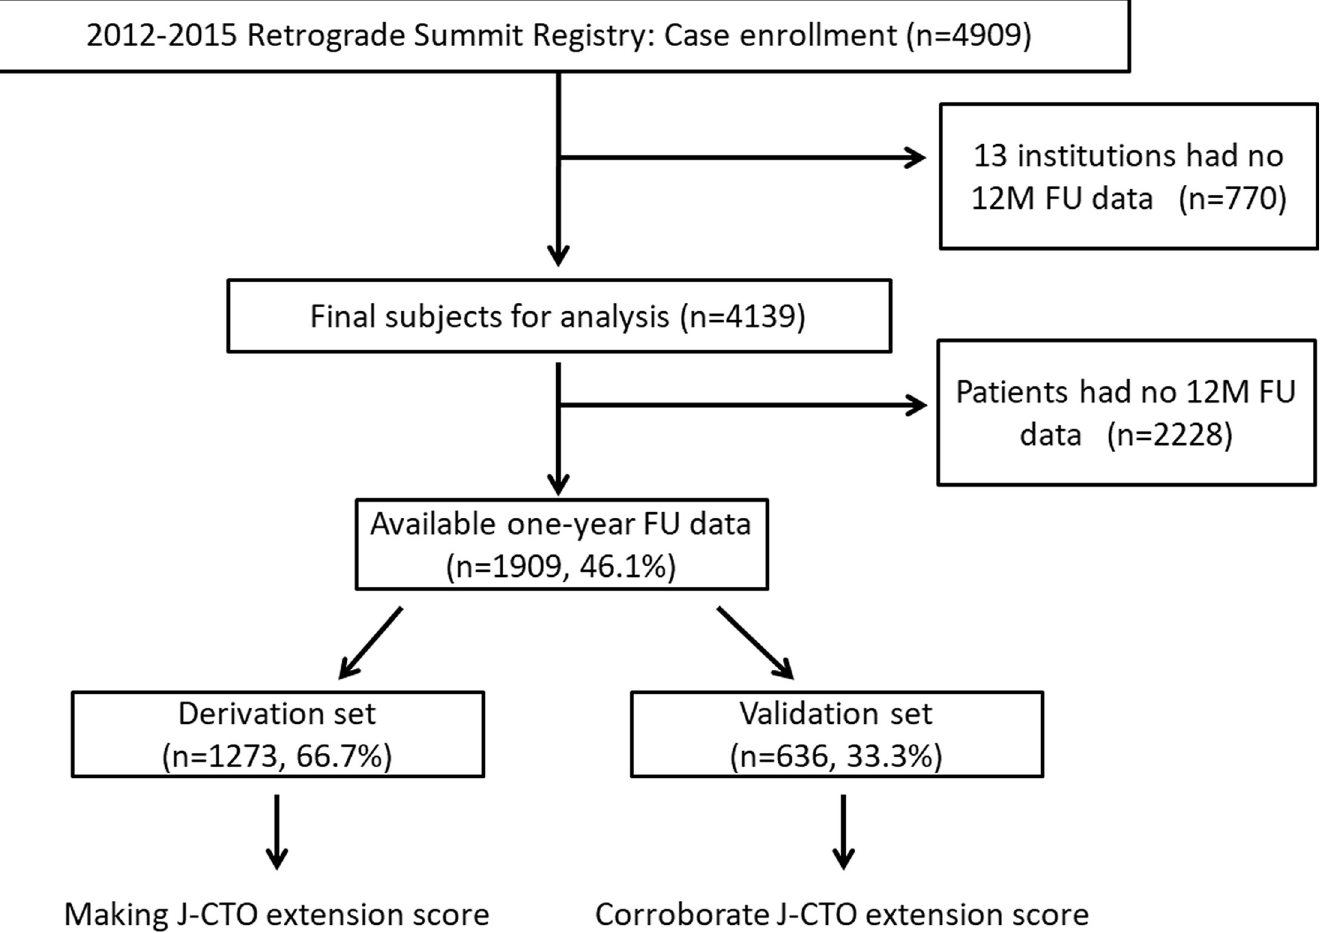
Fig 1. Study flow. When the patients had CTO lesions in several vessels, only the vessel that was treated first was analyzed.